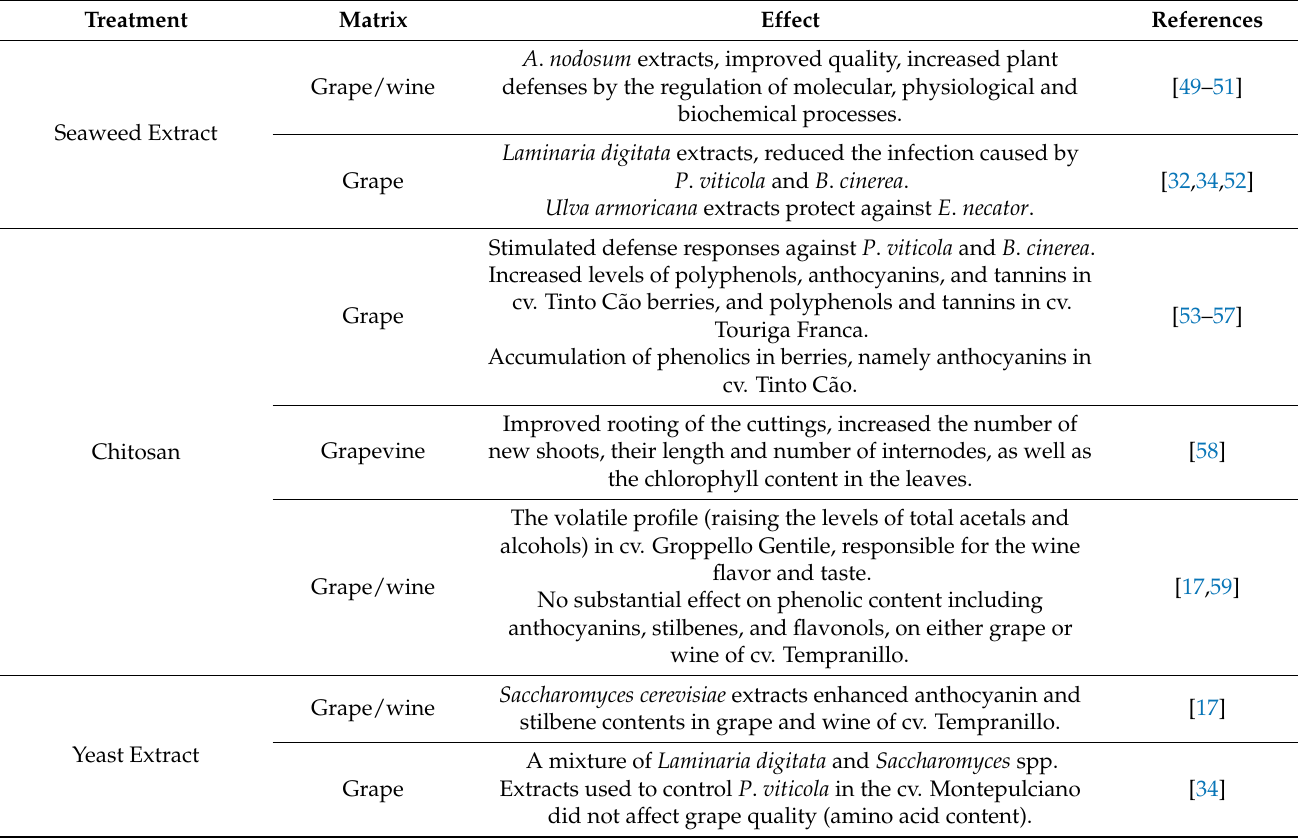
Figure 1. Different biostimulants used as stress alleviators in grapevine. Table 1. Application of different biostimulants in